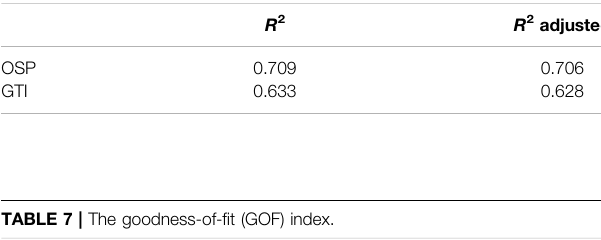
TABLE 6 | Coef fi cient of determination.